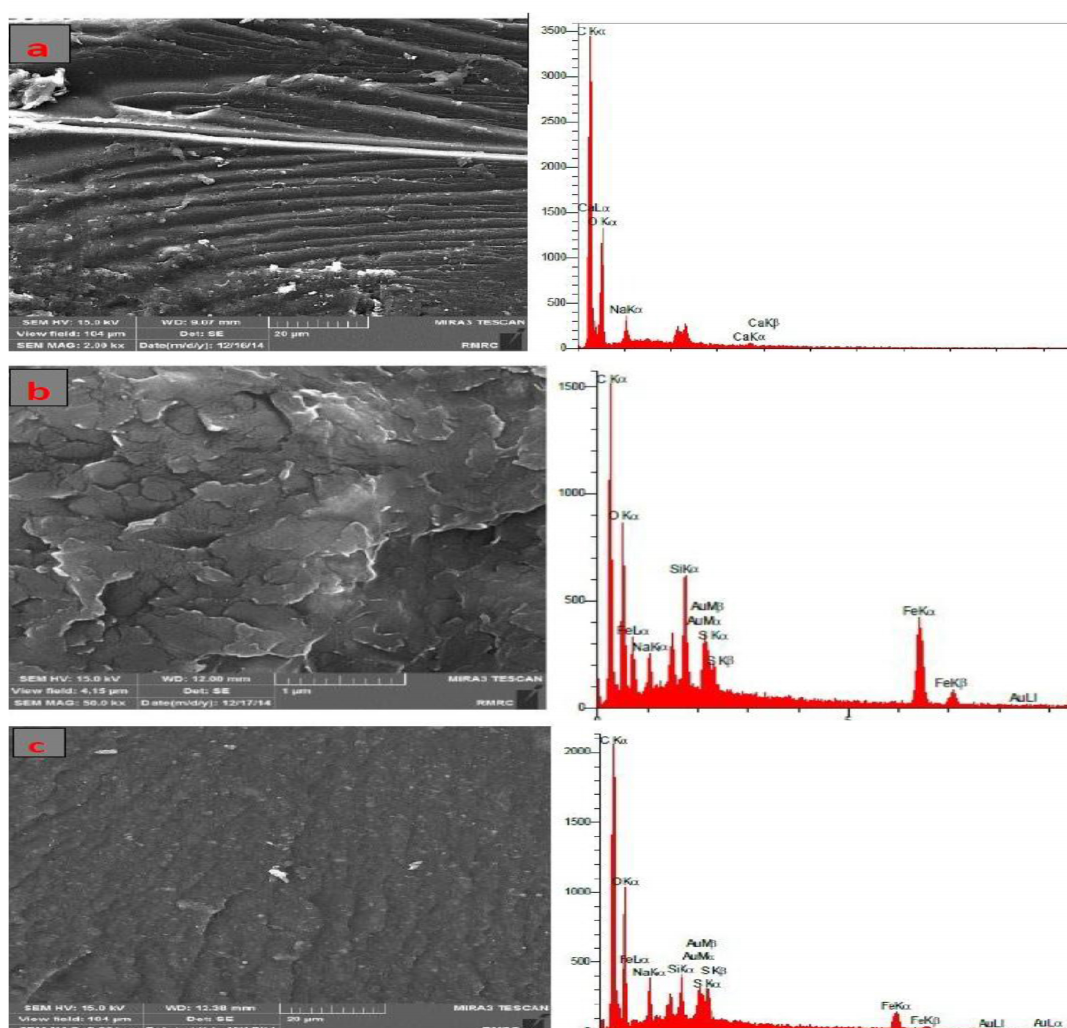
Fig. 2. SEM/EDS images of (a) CMC-g-Am, (b) CMC-g-Am/mMT1 and (c) CMC-g-Am/mMT2